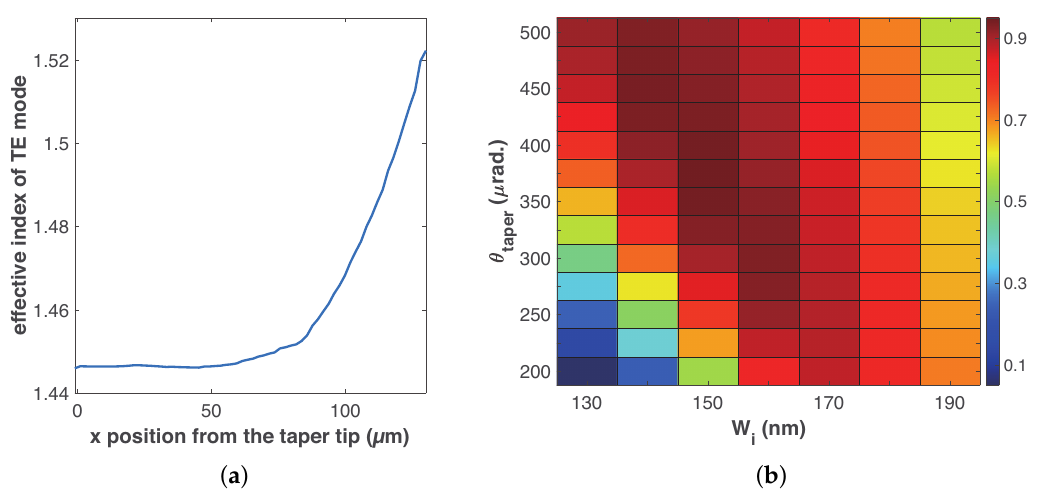
Figure 3. Numerical calculation results. ( a ) Effective index evolution of the structure W i = 150 nm, θ taper = 375 µ rad. ( b ) Modal coupling efficiencies for various W i s and θ taper s. The coupling efficiencies are evaluated at 1550 nm.